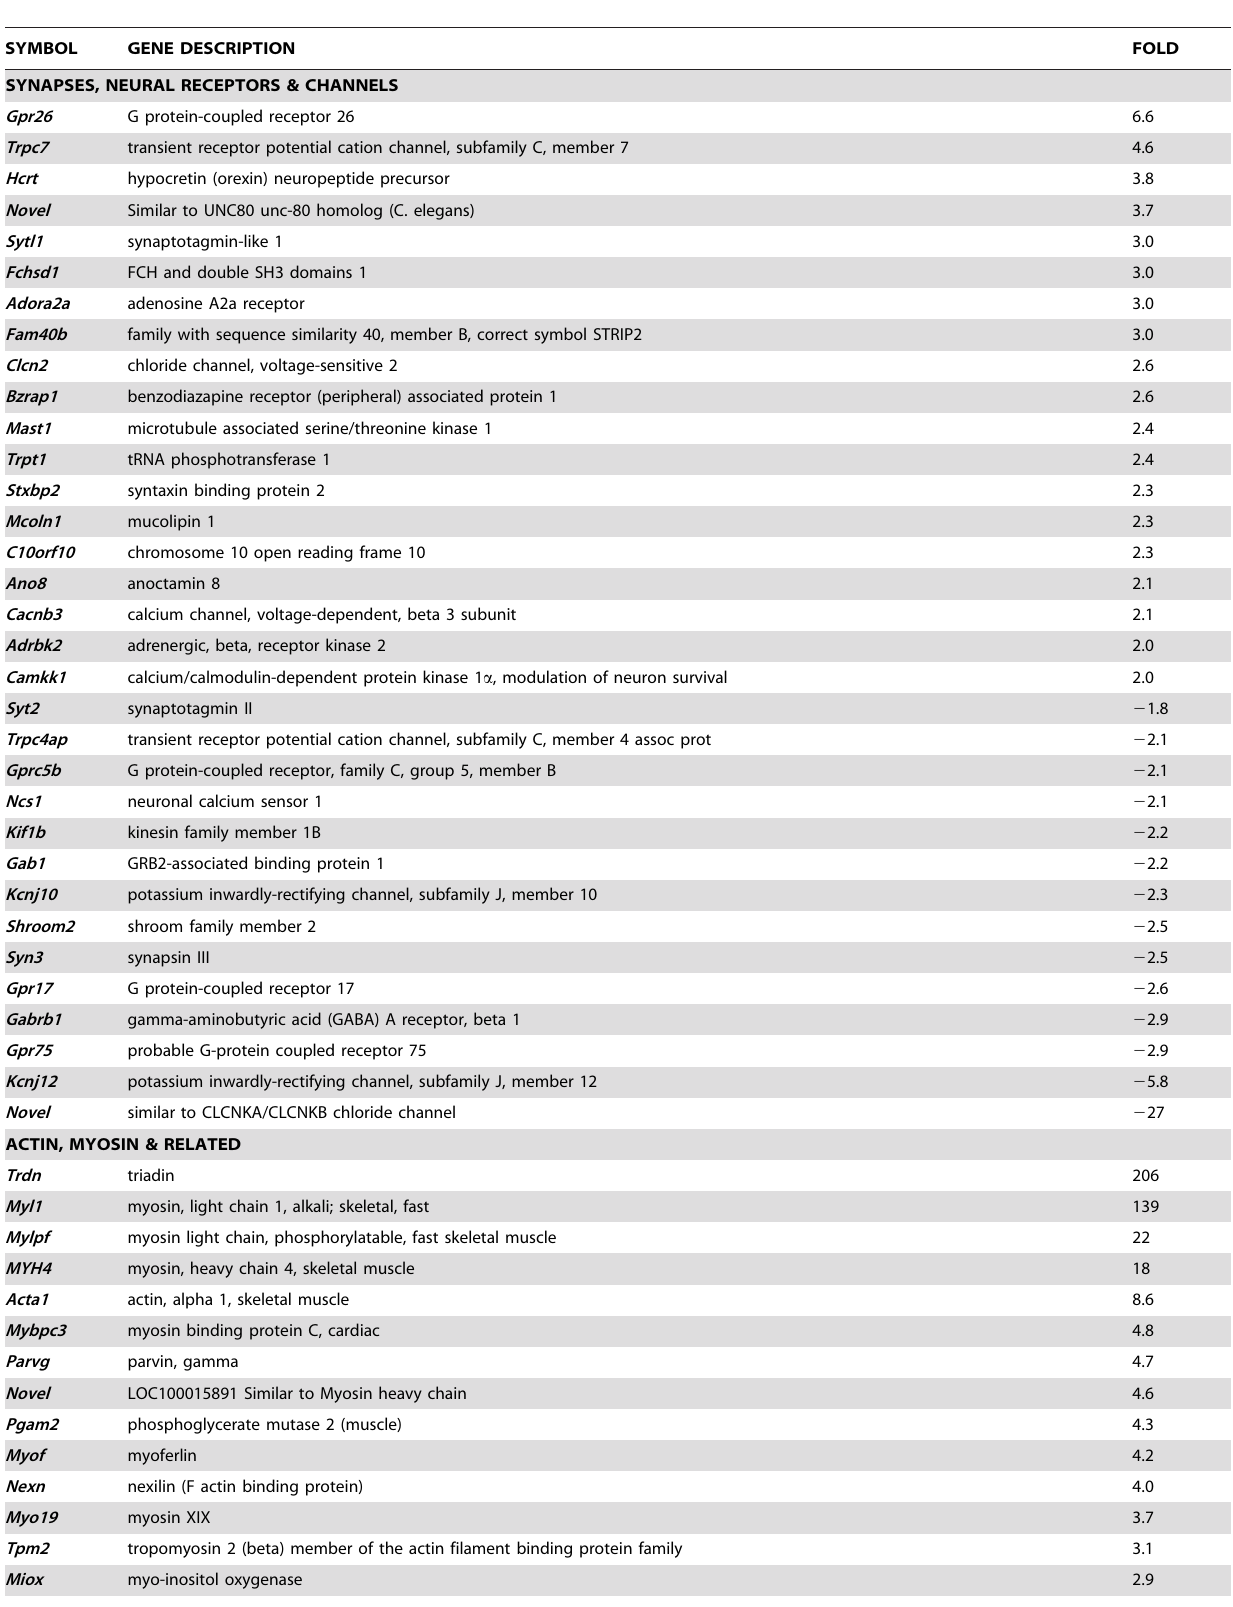
Table 4. Change in expression of channel, synapse, neural receptor, actin, myosin and related genes 24 h following spinal cord injury at